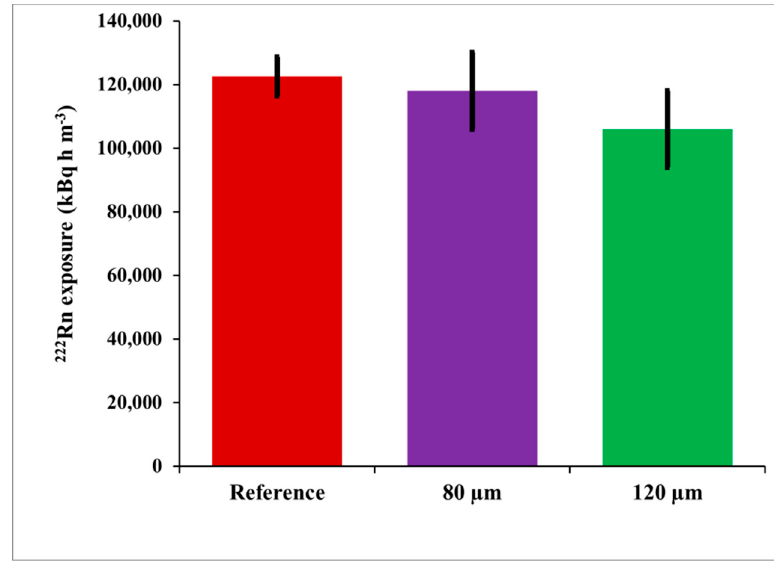
Figure 5. 222 Rn exposure assessed by reference measurements, compact disks (CDs) analyzed at 80 µm and 120 µm deep.